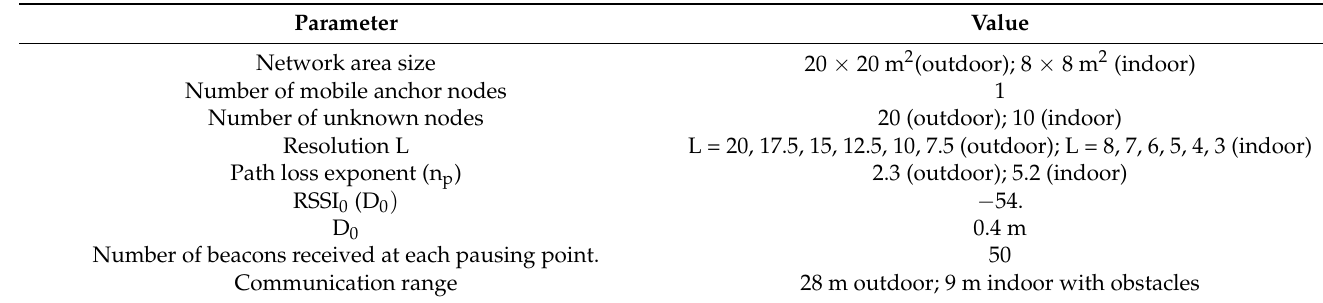
Table 2. Experimental parameters.